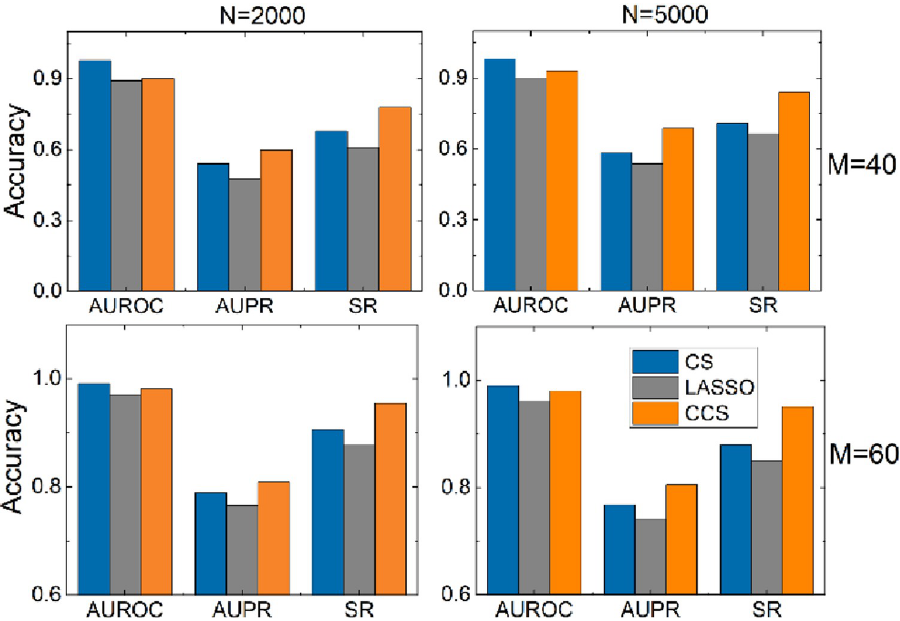
Fig 4. The performance of CCS, CS and LASSO on the scale-free networks with 2000, 5000 nodes, and sample sizes are 40, 60, respectively.